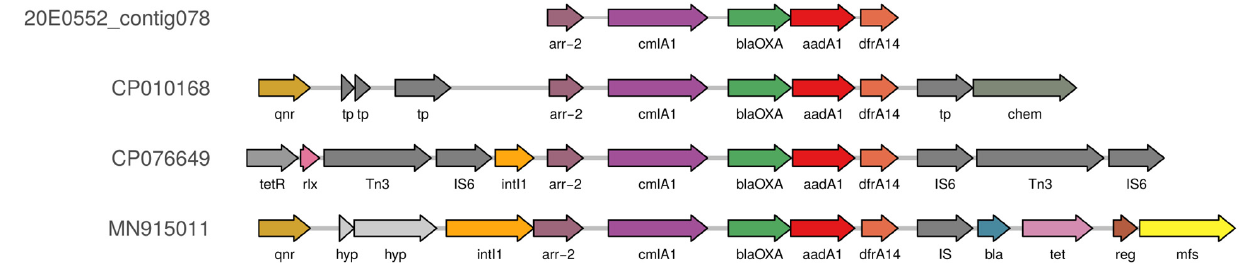
Figure 4. arr -2 resistance gene cassette from strain 20E0552 in its sequence context from different plasmids. The resistance gene cassette containing the arr -2 gene from contig78 of the WGS assembly for E. coli strain 20E0552 is shown. The identical resistance cassettes of three different E. coli plasmids taken from GenBank are shown beneath contig78 with their respective flanking sequences. The accession numbers of the plasmids are listed on the left. Genes are depicted as arrows, and their annotations are from the GenBank files. The image was generated with gggenes (v. 0.4.1).